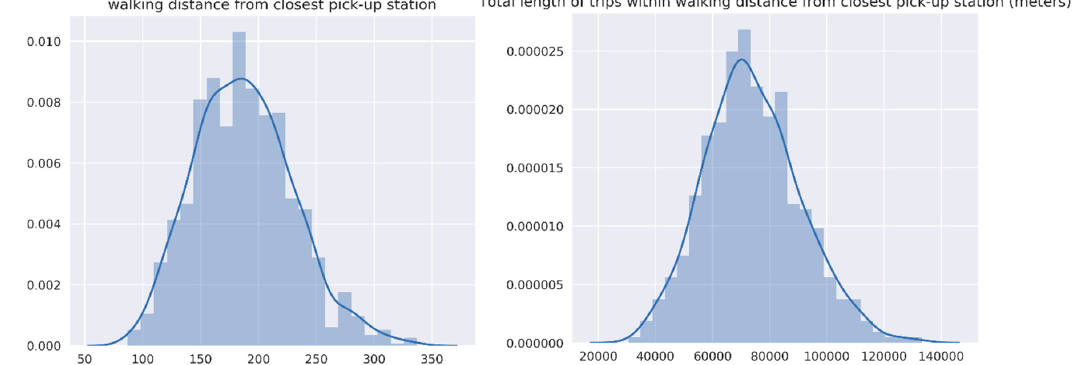
Figure 8. Total number of purchases from trips within walking distance.